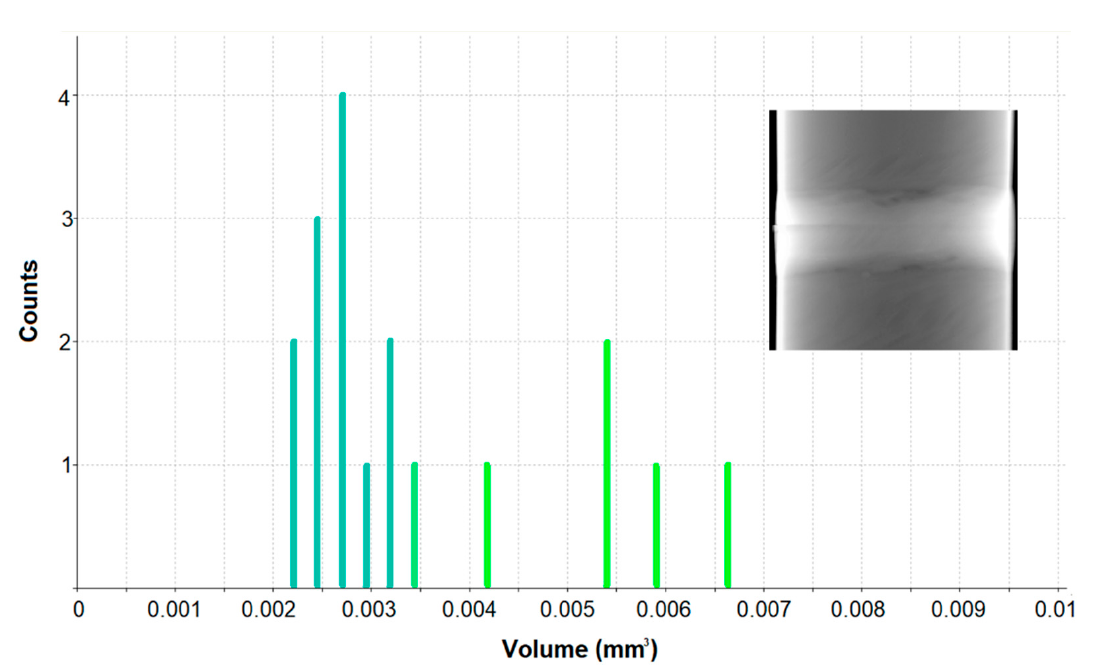
Table 4. Defect parameters evaluated by computed tomography (CT).